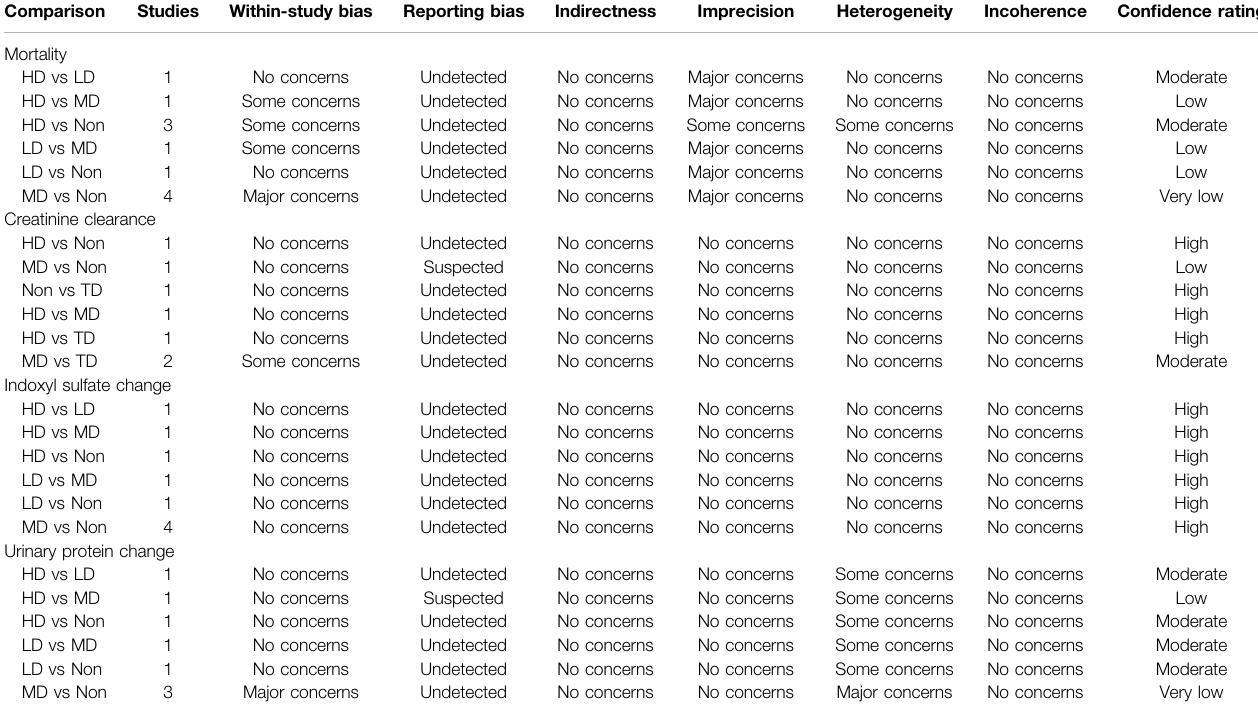
TABLE 3 | Con fi dence rating for fi ndings from complete network meta-analysis.